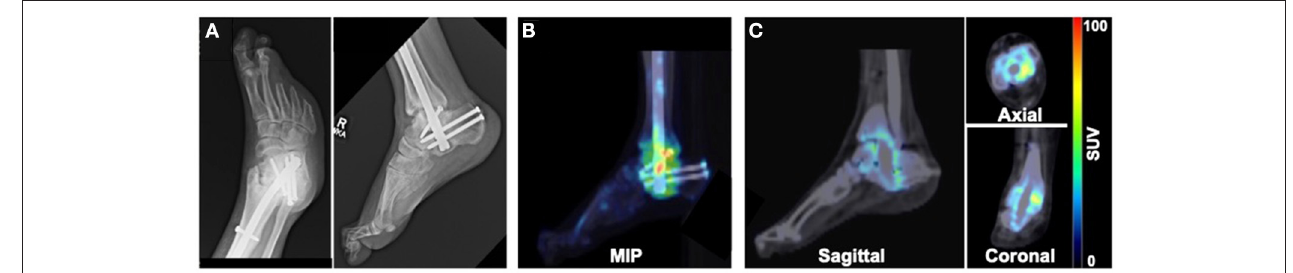
FIGURE 3 | Imaging evaluation of 40-year old male patient with history of Charcot joint of the right ankle. (A) X-rays acquired 9 months after surgical reconstruction revealed stable bone architecture. (B) MIP and (C) PET/CT images acquired 9 months after surgery demonstrated focal uptake of 18 F-NaF in the region of the surgically reconstructed ankle impacted by CN, suggesting ongoing remodeling of the bones of the ankle.